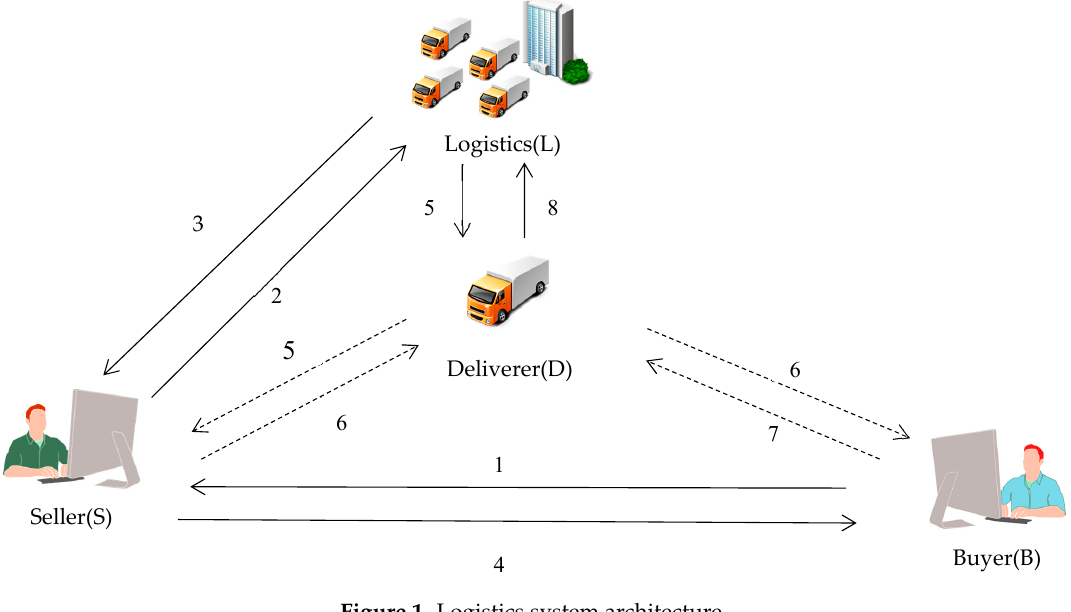
Figure 1. Logistics system architecture.